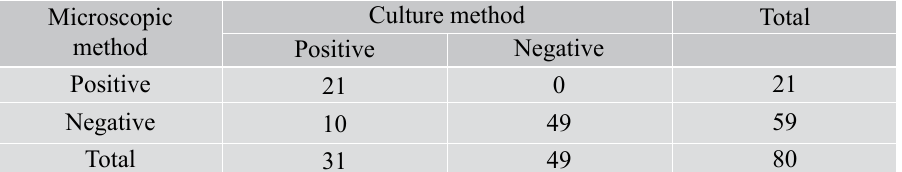
Table III: Detection rate of dermatophytes by culture and microscopy Table IV: Comparison between microscopic examination and culture method for detection of dermatophytes